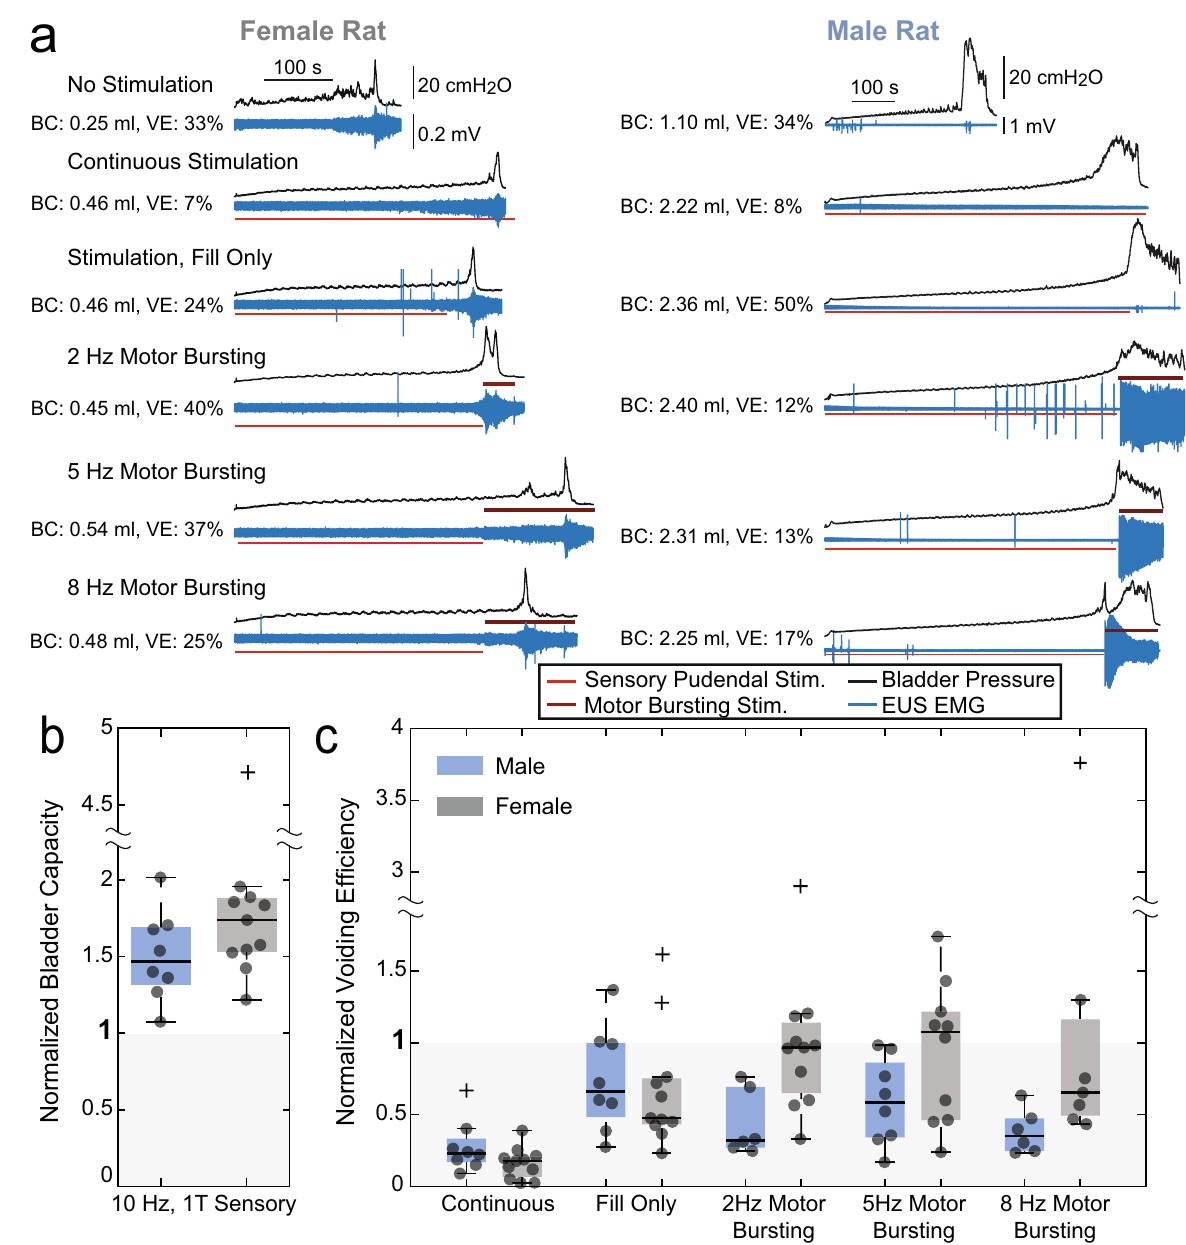
Figure 2. State-dependent stimulation restored both continence and efficient bladder emptying in male (n = 8) and female (n = 11) rats. ( a ) Cystometrograms from single experiments showing bladder pressure (black) and sphincter EMG (blue). Red lines indicate the duration of sensory pudendal stimulation (10 Hz, 1 T) to inhibit the bladder and promote storage. Brown lines above the traces indicate the duration of motor bursting stimulation (3 pulses at 40 Hz at the indicated burst repetition frequency) to activate the bladder and promote emptying. Average BC and VE for each type of trial for the example experiment are listed next to the traces. ( b ) BC for all experiments relative to controls. All relevant trials within an experiment were averaged resulting in a single data point for each experiment. Averages were 148% (males, P = 0.0008, n = 8) and 180% (females, P = 0.0002, n = 11). ( c ) VE for all stimulation conditions relative to controls. Continuous stimulation decreased VE relative to controls (males: 24%, P = 0.0006, n = 8; females: 12%, P < 0.0001, n = 11). State-dependent stimulation increased VE relative to continuous stimulation. In females motor-bursting stimulation increased VE beyond the stimulation during fill-only condition (2 Hz: P = 0.0049, n = 11; 5 Hz: P = 0.010, n = 10; 8 Hz: P = 0.0082, n = 7). In males, the largest increase in VE was the fill-only condition, increasing VE from 12 to 66% relative to control values (P = 0.011, n = 8). Box plots have a line at the median and the box extends from the estimated 25th to 75th percentiles. Lines beyond the box show the extent of data points that were not considered to be outliers ( boxplot function, Matlab). Outliers are plotted as ‘+’ marks although all data were included for analysis. Paired t tests were used for BC comparisons. Mixed-effects